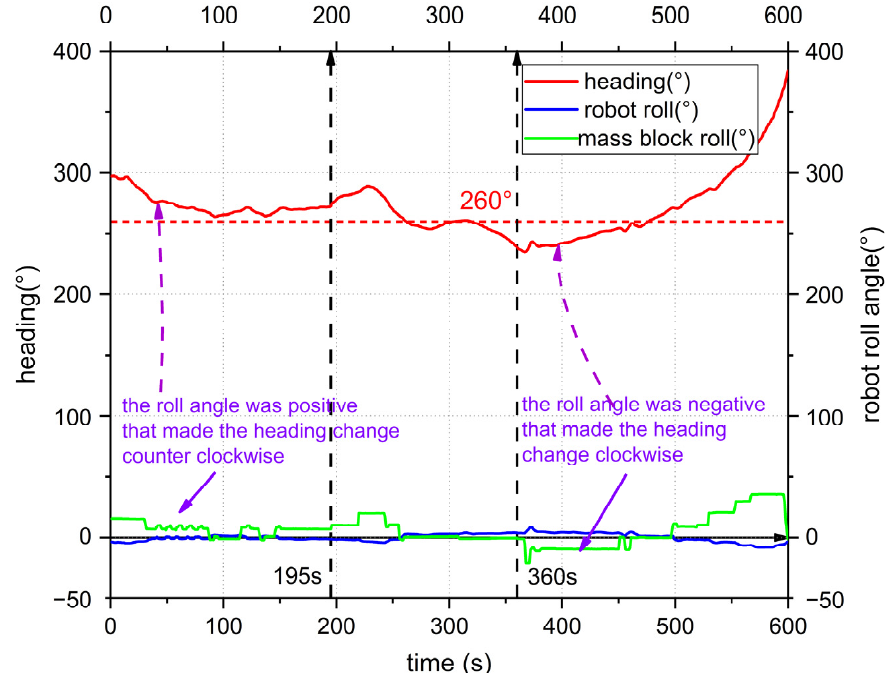
Figure 8. The heading, robot roll angle, and mass block roll angle changed with time. The dotted red